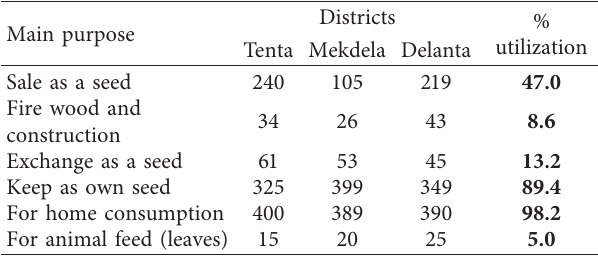
Table 2: Frequencies of local farmers citing the main purposes for growing local sorghum grains in the study